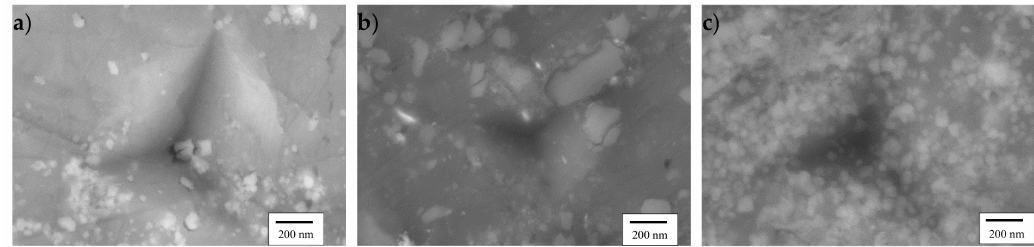
Figure 5. HRSEM micrographs of typical nanoindents on ( a ) M10S n -mixed; ( b ) M10S µ ; and ( c ) M10S n